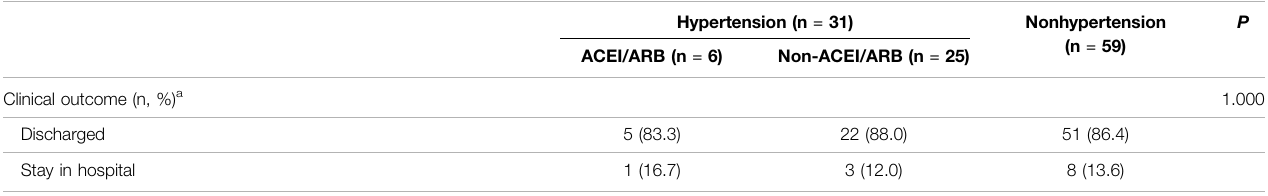
TABLE 2 | ( Continued ) The comparison of demographic and clinical characteristics, laboratory and radiology fi ndings, clinical measures, clinical outcomes, and severity of COVID-19 among ACEI/ARB, non-ACEI/ARB, and nonhypertension